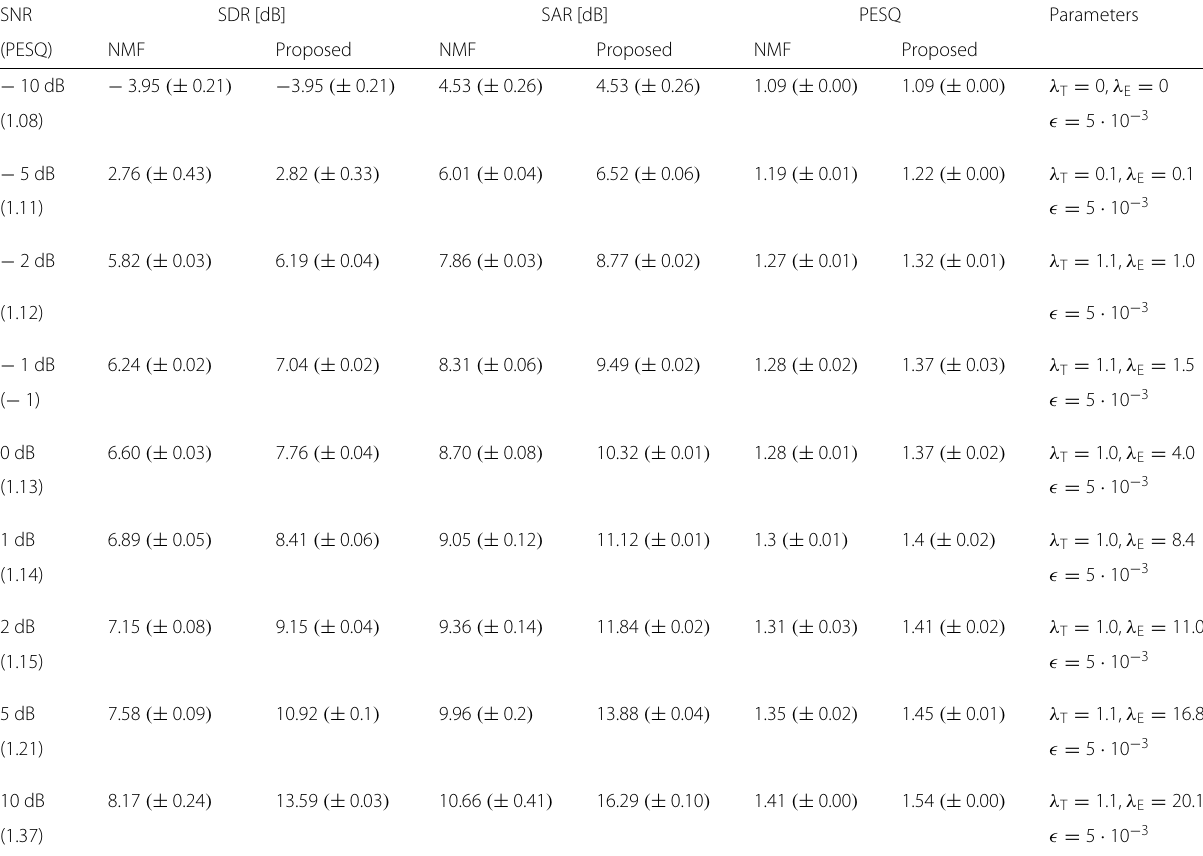
Table 2 Suppression performance achieved by NMF and the proposed method for varying SNRs. For this experiment, ego-noise by movements of Sequence I is used. Parameters used for proposed methods are given in the last rows. For all SNRs, dictionaries of size K = 20, K S = 20 are